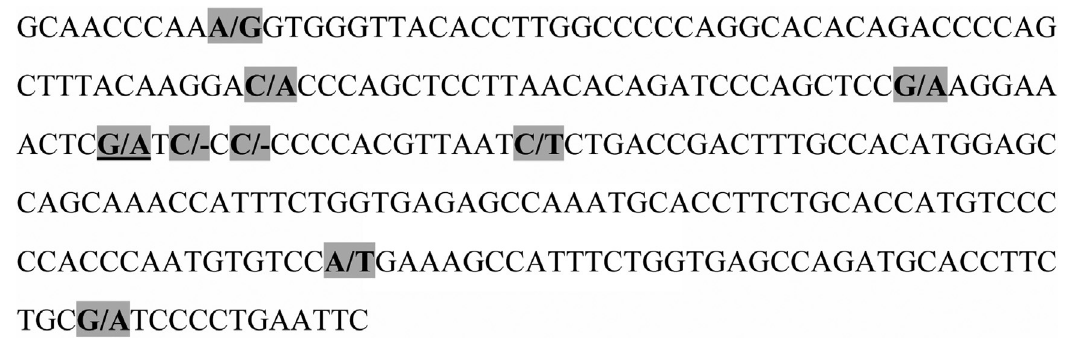
Figure 1 - Distribution of common SNPs and indels within the range from 99 bp upstream to 156 bp downstream of rs9263726. The underlined bases are the position of rs9263726 (G > A). Bases with gray shading represent the indel or SNP and its allele